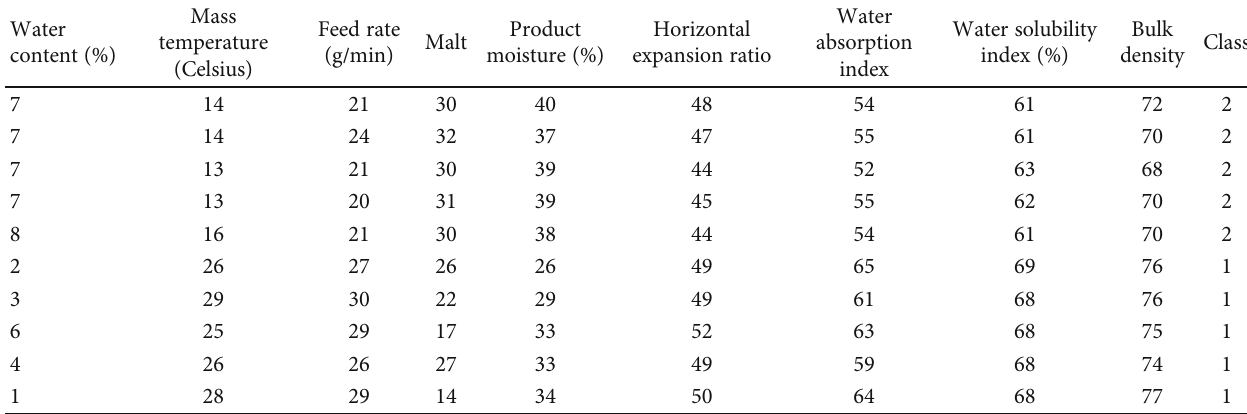
Table 1: A subset of the bread dataset.